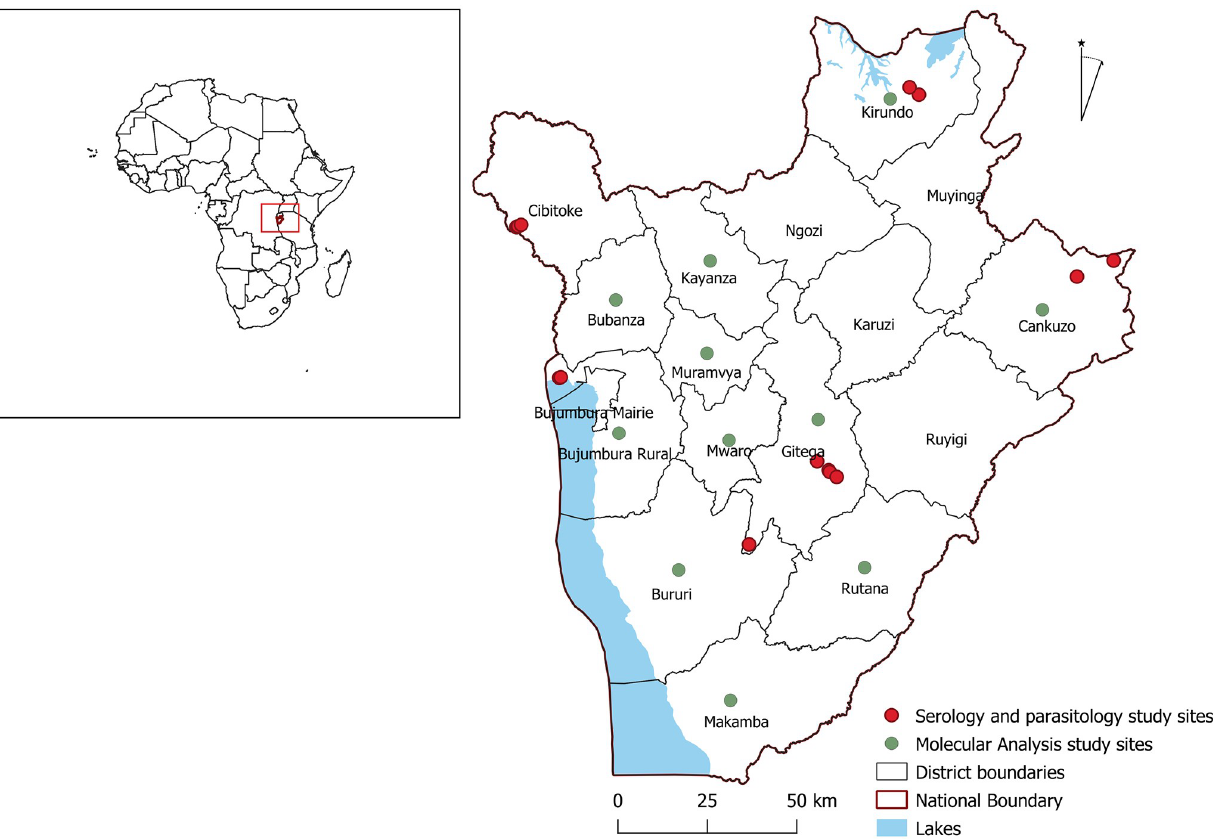
Fig 1. Map of Burundi showing the provinces and sites where sampling of cattle was conducted. Colour codes indicate the areas were samples for microscopic examination, serology and molecular analysis were collected. The regions were broken down as follows; Northern region (Kirundo province), Southern region (Makamba province), Eastern region (Rutana province), Western region (Bujumbura, Bubanza, Cibitoke and Bururi provinces), Central region (Muramvya, Mwaro, Gitega and Kayanza provinces) and North-Eastern region (Cankuzo province).